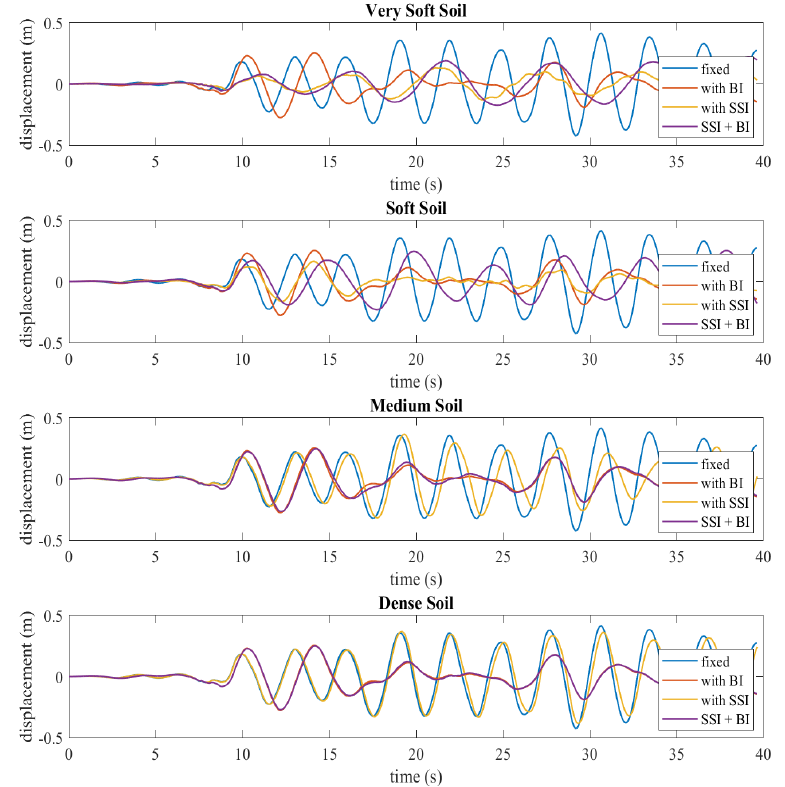
Figure 10. Top story displacement–time history of forty ‐ story buildings (Imperial Valley, 1979).